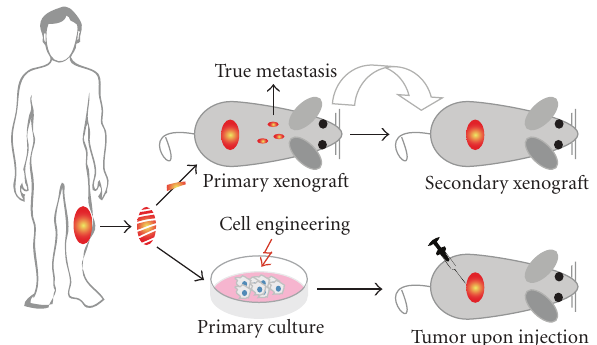
Figure 3: Human cell lines and xenografts . Schematic representation of how xenografts and cell cultures are established from human osteosarcoma. After excision, the tumor is dissected into pieces of which one ore more can be subcutaneously—or when technically possible orthotopically—xenotransplanted into nude mice. Please note that when dissemination is found in this situation, these cells should be originating from the primary tumor and more closely representing true metastasis. Subsequently, the process of xenotransplantation can be repeated as often as needed to keep the human tumor “alive” providing a source for research material. Alternatively, after tumor excision, cell cultures can be established. Subsequently, cells can be engineered—like the human osteosar- coma cell line HOS—and injected into mice to assay the tumori- genicity, metastatic potential, and other features. When established xenografts and cell lines are shown to represent certain aspects of human osteosarcoma, they can be used as